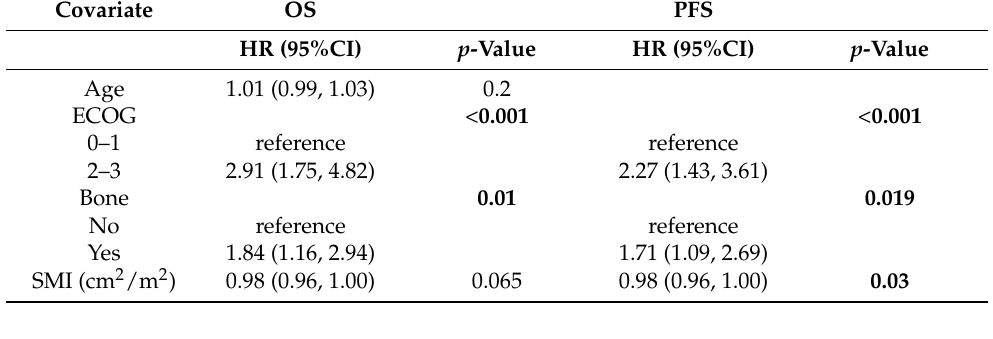
Figure 2. Time-dependent AUC for OS. Clinical variables include ECOG performance status and bone metastases.